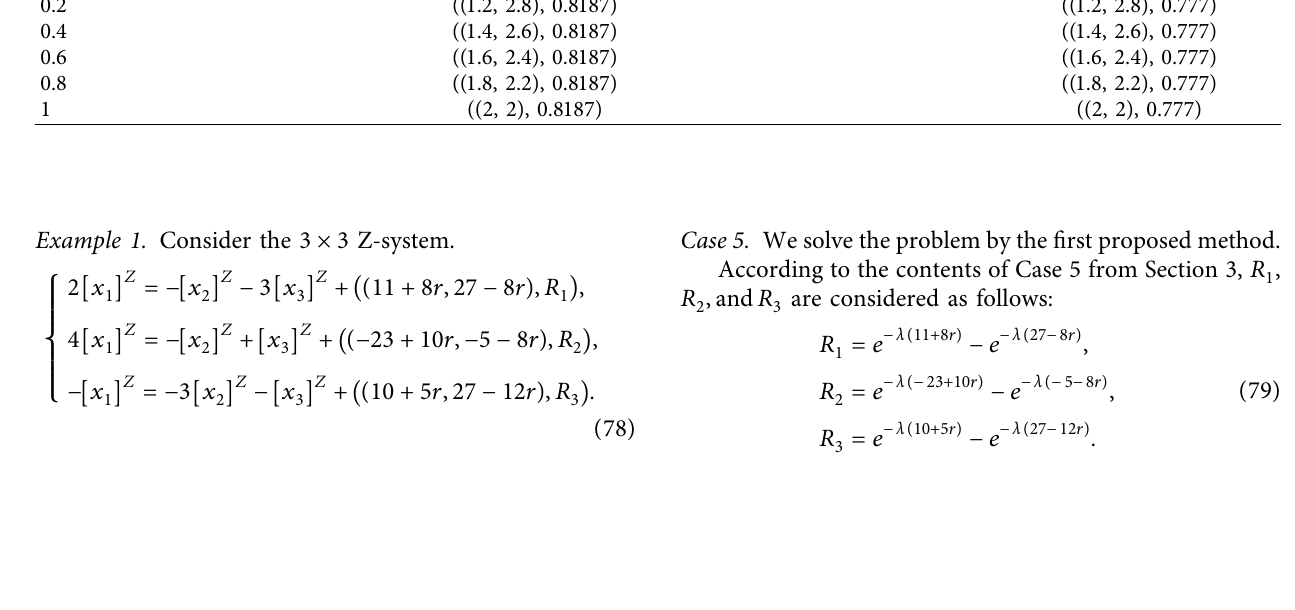
Table 7: Comparison of 􏽥 u ( r ) result using the two proposed methods ( λ � 0 . 05 ) . 2 Te frst proposed method ( λ � 0 . 05